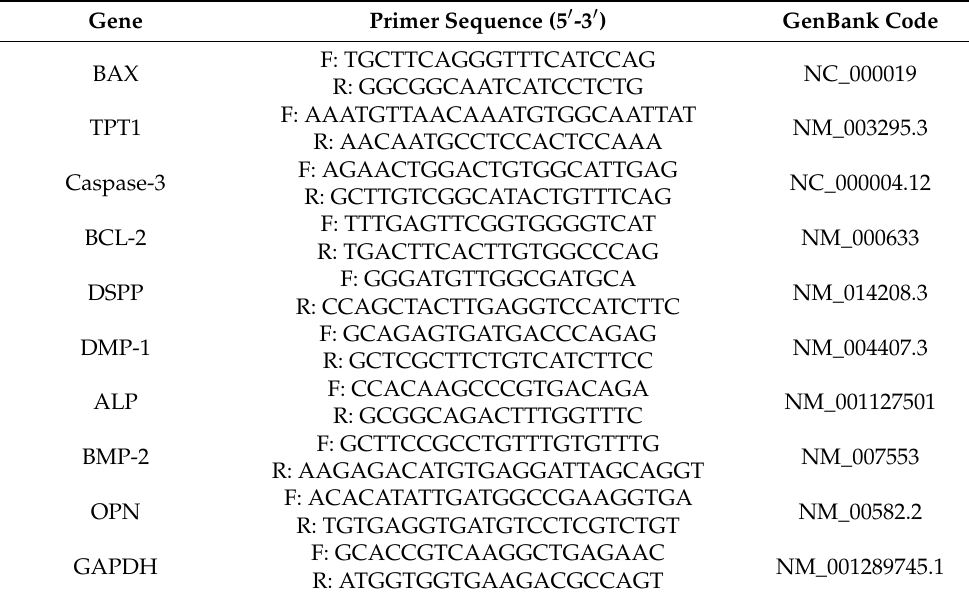
Table 2. The oligonucleotide primer sequences of qRT-PCR analysis